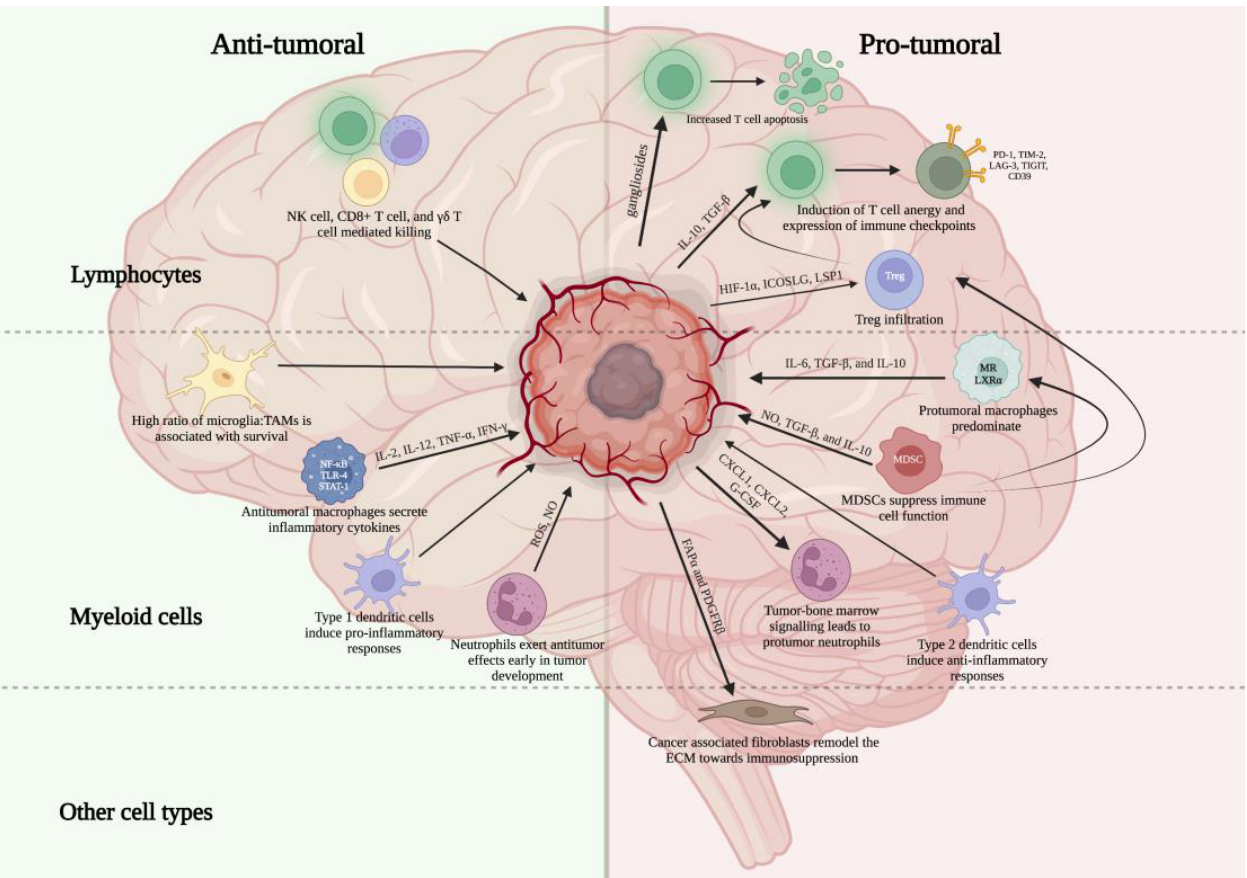
Figure 1. Overview of key pro- and anti-tumor immune cell populations within the glioblastoma microenvironment. Created with Biorender.com. Table 1. Summary of immune cell infiltration of GBM.